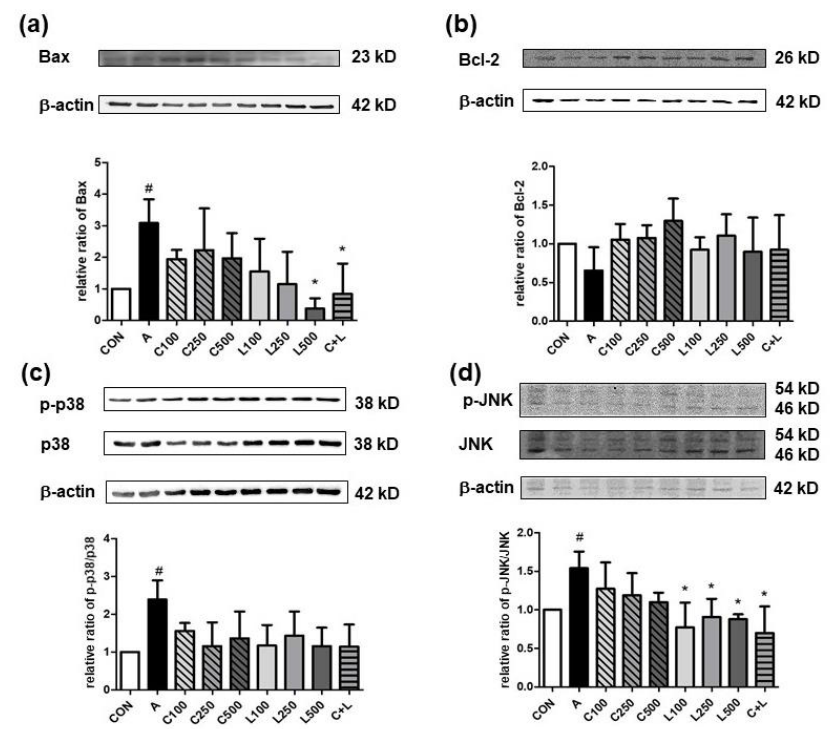
Figure 5. Effects of aspirin, CPC, and/or LBP on the relative ratio of ( a ) Bax, ( b ) Bcl-2, ( c ) phosphor- ylated p38 (p-p38)/p38, and ( d ) phosphorylated c-Jun N-terminal kinase (p-JNK)/JNK. CON: control group, A: aspirin-induced group, C: CPC treated group, L: LBP treated group. Data are mean ± SD ( n = 4). # p < 0.05 compared with the CON group. * p < 0.05 compared with the A group.